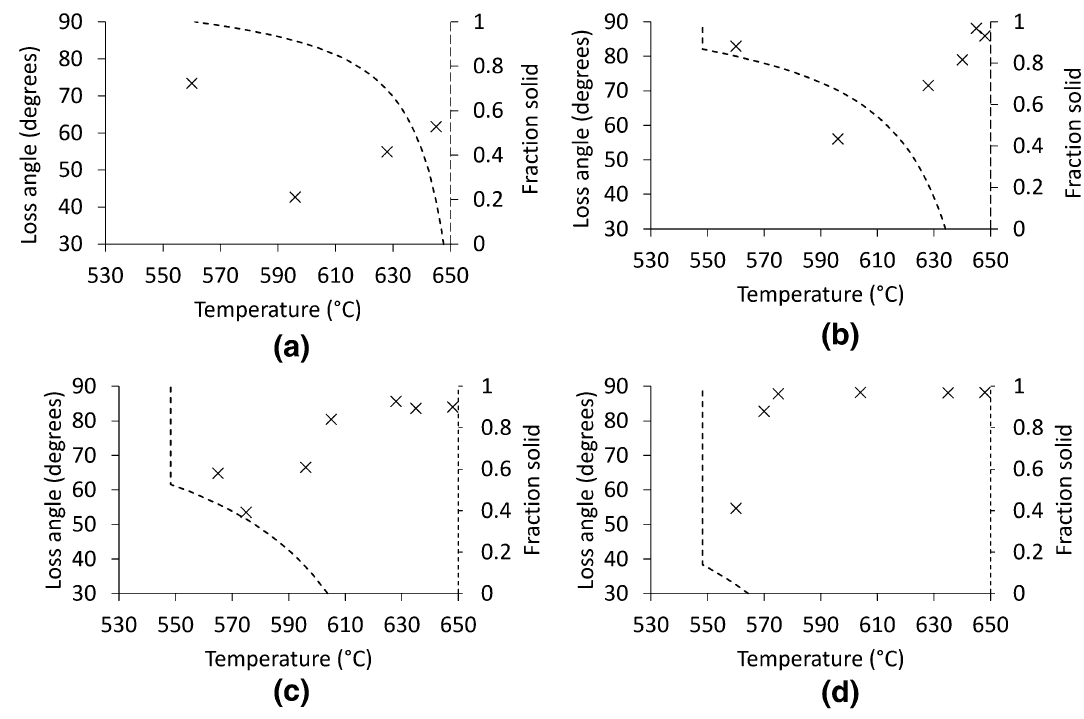
Fig. 10 Loss angle δ for the oscillatory measurements in Fig. 7- a 5%, b 10%, c 20% and d 30% (by weight) Cu